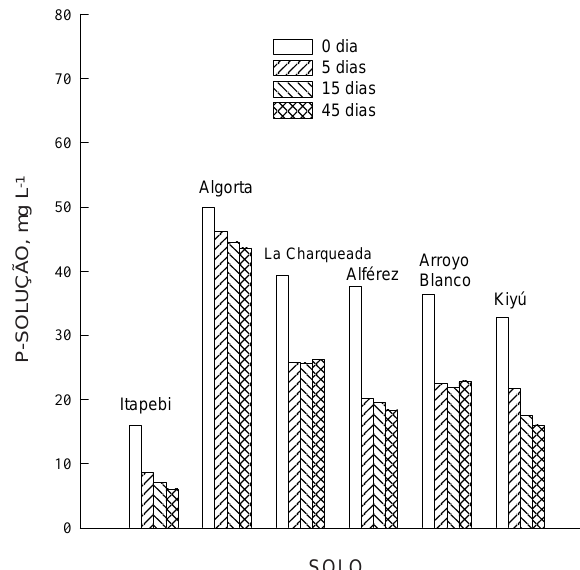
Figura 4. Teores de P na solução dos seis solos, após a adição de uma quantidade equivalente a dose de 600 mg kg -1 de P às amostras originais e às que foram submetidas aos períodos de alagamento e de secagem por 21 dias.